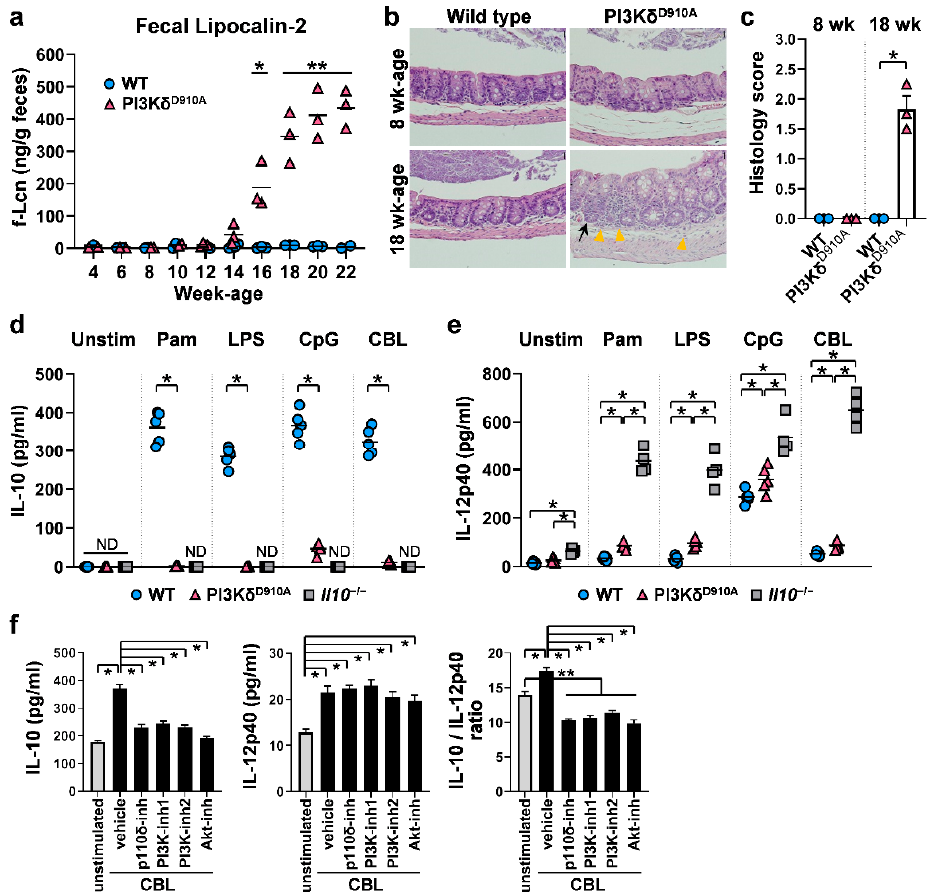
Figure 1. Inflammatory or regulatory phenotypes are determined by PI3K δ signaling. ( a ) The time course of concentrations of fecal lipocalin-2 (f-Lcn) from wild-type (WT) and PI3K δ D910A mice. ( b ) Representative images of H&E-stained cecal samples from C57BL / 6 wild-type mice (WT) or PI3Kp110 δ D910A / D910A mice (PI3K δ D910A ) at 8 and 18 weeks of age. The scale bars represent 100 µ m. Black arrow indicates crypt hyperplasia. Yellow arrowhead indicates infiltration of neutrophils and lymphocytes. ( c ) Histology scores of WT or PI3K δ D910A mice at 8 and 18 weeks of age are shown. ( d,e ) 1 × 10 6 unfractionated mesenteric lymph node (MLN) cells from WT, PI3K δ D910A or IL-10-deficient ( Il10 − / − ) mice were cultured with medium alone (unstim), Pam3CSK4 (Pam, 100 ng / mL), lipopolysaccharide (LPS, 200 ng / mL), CpG-DNA (CpG, 500 nM) or cecal bacterial lysate (CBL, 10 µ g / mL) in complete medium for 24 h at 37 ◦ C with 5% CO 2 . Supernatant levels of ( d ) IL-10 and ( e ) IL-12p40 were quantified by ELISA. ( f ) 1 × 10 6 unfractionated cLP from WT mice were cultured with or without CBL (10 µ g / ml) in the absence or presence of specific PI3K / AKT-related inhibitors or vehicle control in complete medium for 24 h. IL-10 and IL-12p40 levels in cell culture supernatants were measured by ELISA and IL-10 / IL-12p40 ratios were calculated. PI3K / Akt-related inhibitors: PI3Kp110 δ -selective inhibitor (p110 δ -inh, IC87114, 2 µ M), PI3K-global inhibitors (PI3K-inh1: LY294002, 2 µ M and PI3K-inh2: wortmannin, 0.5 µ M); Akt inhibitor (Akt-inh, API-2, 0.5 µ M). Vehicle control: dimethyl sulfoxide. N = 4-5 / group. Each